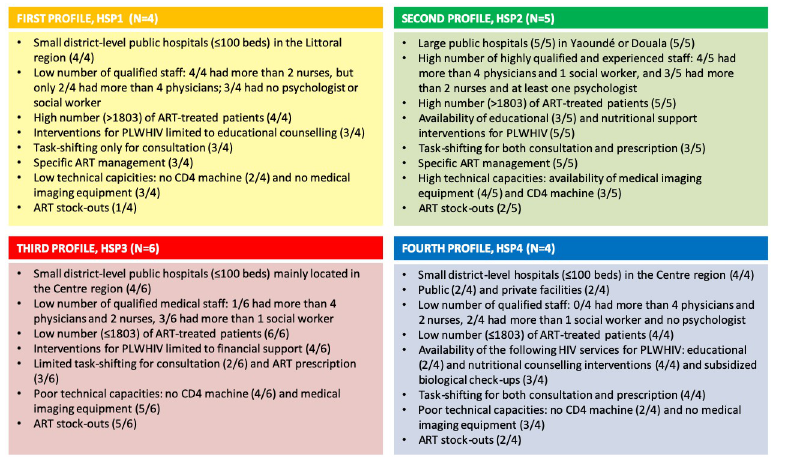
Fig 1. Main features of each HIV-service profile (EVOLCam survey, ANRS 12288). Abbreviations: ART = Antiretroviral treatment; ARV = Antiretroviral drugs; PLHIV = People Living with HIV.